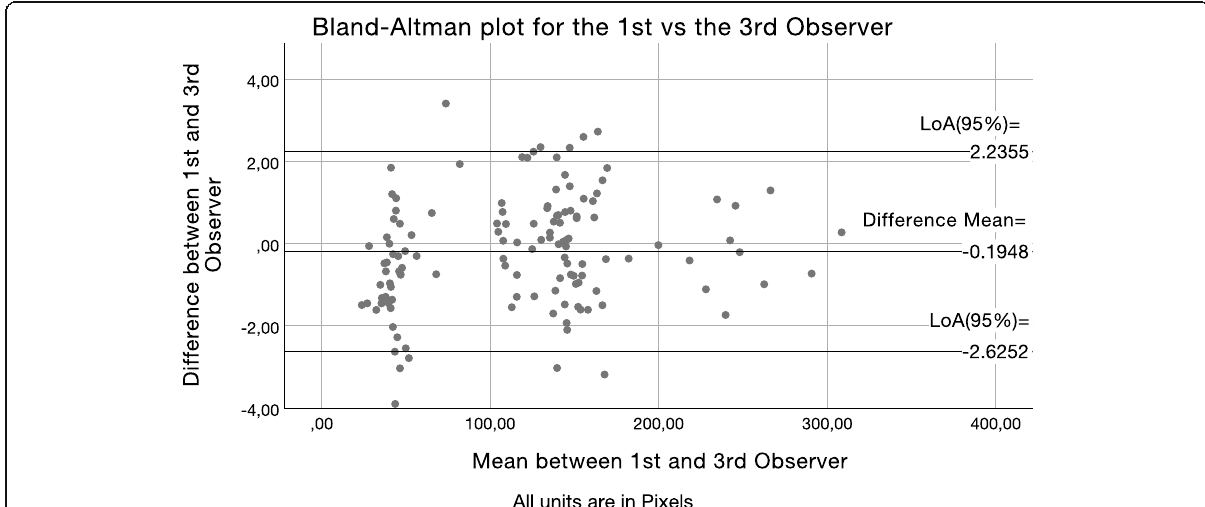
Fig. 5 Bland – Altman scatter plot of the difference between first observer ’ s average measurements versus the third observer ’ s. Y -axis: Difference between the first observer and the third observer (B). X -axis: Average of their measures. Difference mean: Estimated bias between the first observer and the third observer (B). LoA 95% limits of agreement at the 95% confidence interval